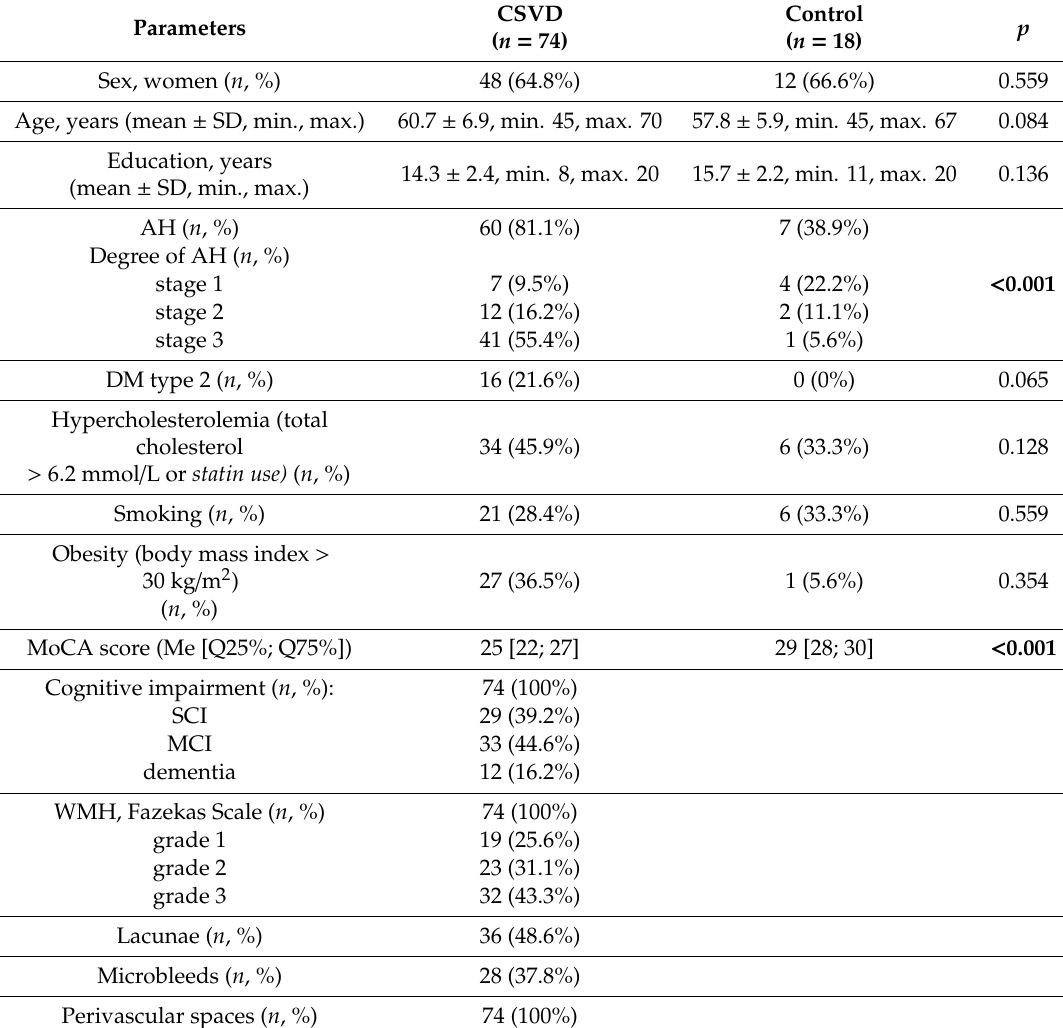
Table 1. Characteristics of patients with cerebral small vessel disease (CSVD) and the controls. Parameters